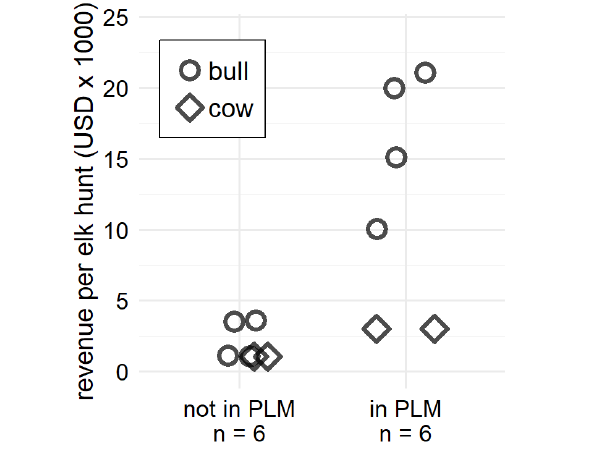
Fig. 6. The reported average hunting revenue per elk for